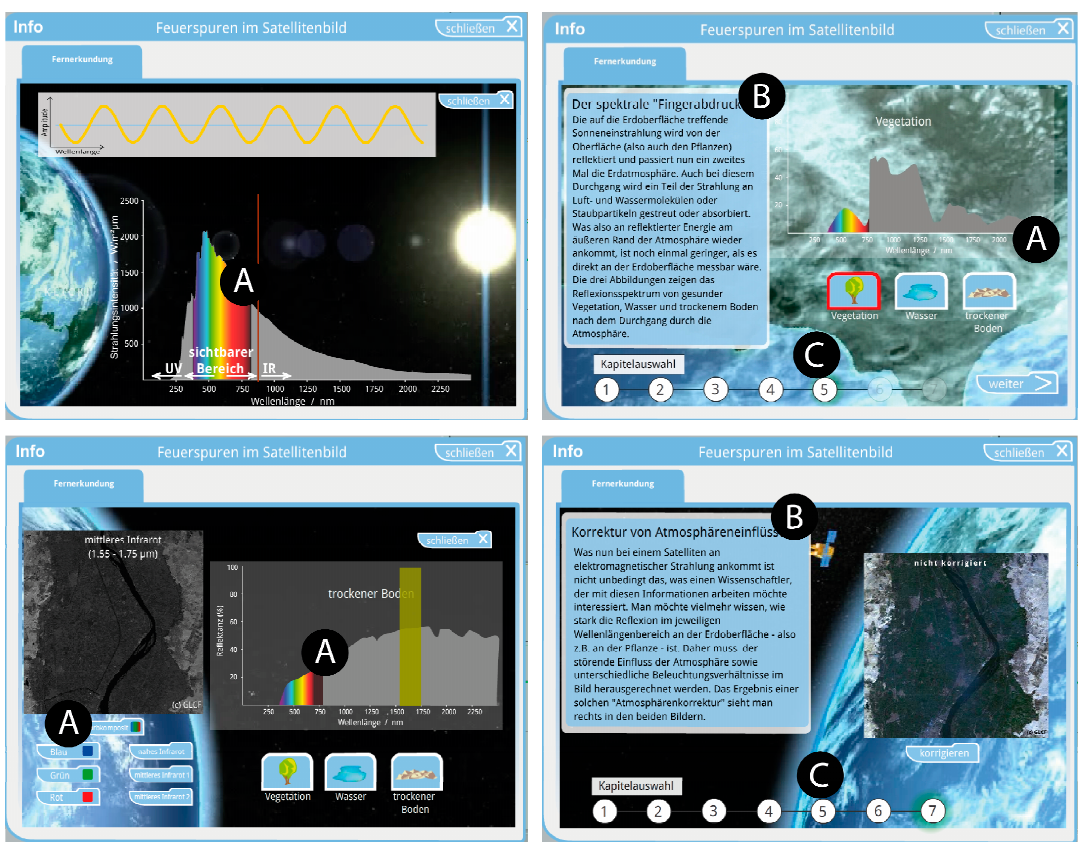
Figure 9. Presumed incorrect use of the “Coherence Priciple”. ( A ) Interaction/Animation; ( B ) Text; ( C ) Chapter Indicatior (Source: see Appendix